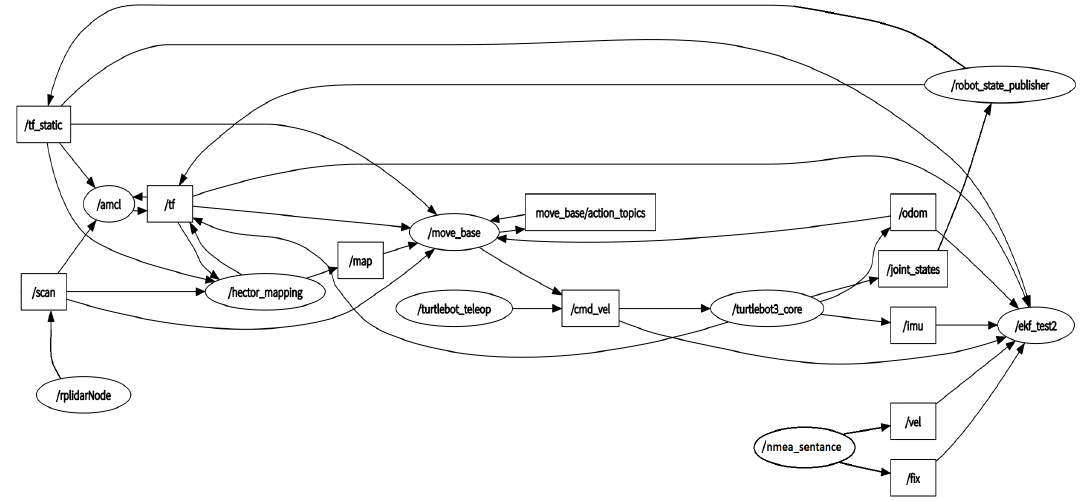
Figure 11. Robot operating system (ROS) system topic structure